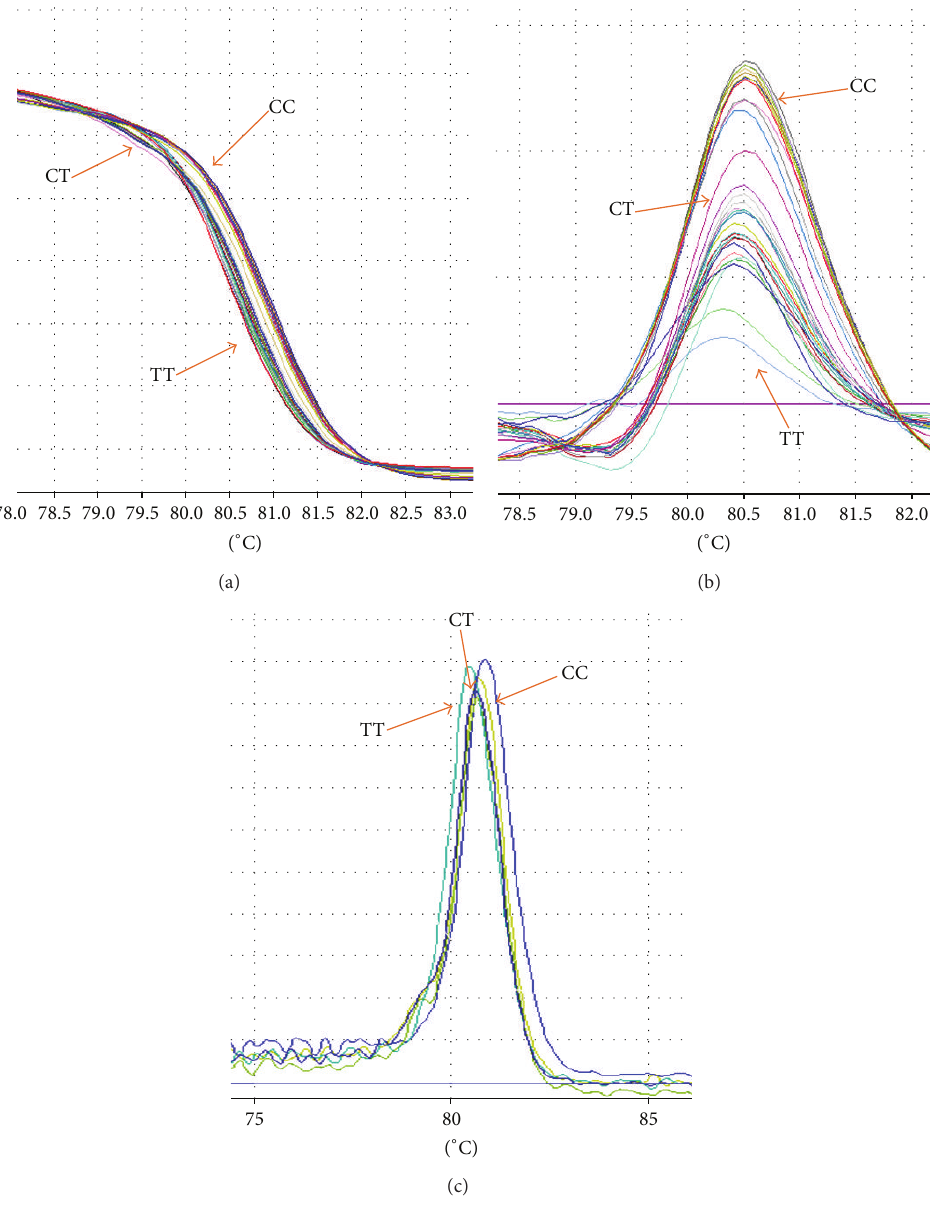
Figure 3: The difference graph of HRM analysis for the genotypes of R230C polymorphism. (a) demonstrated the normalized graph, (b) revealed the difference graph, and (c) was melting graph. In these graphs WT had higher Tm and HOM had lower